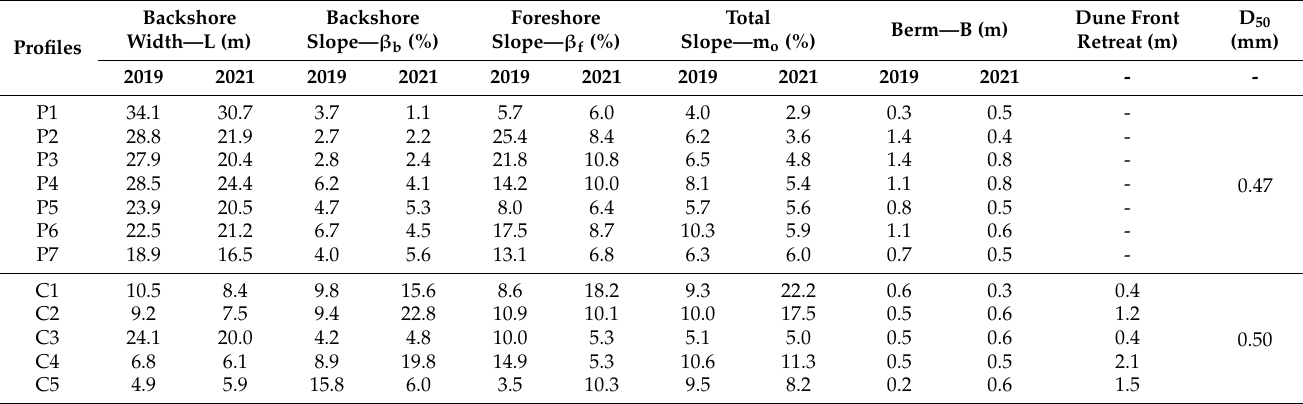
Table 5. Comparison of main morphometric features of beach profiles in 2019 and